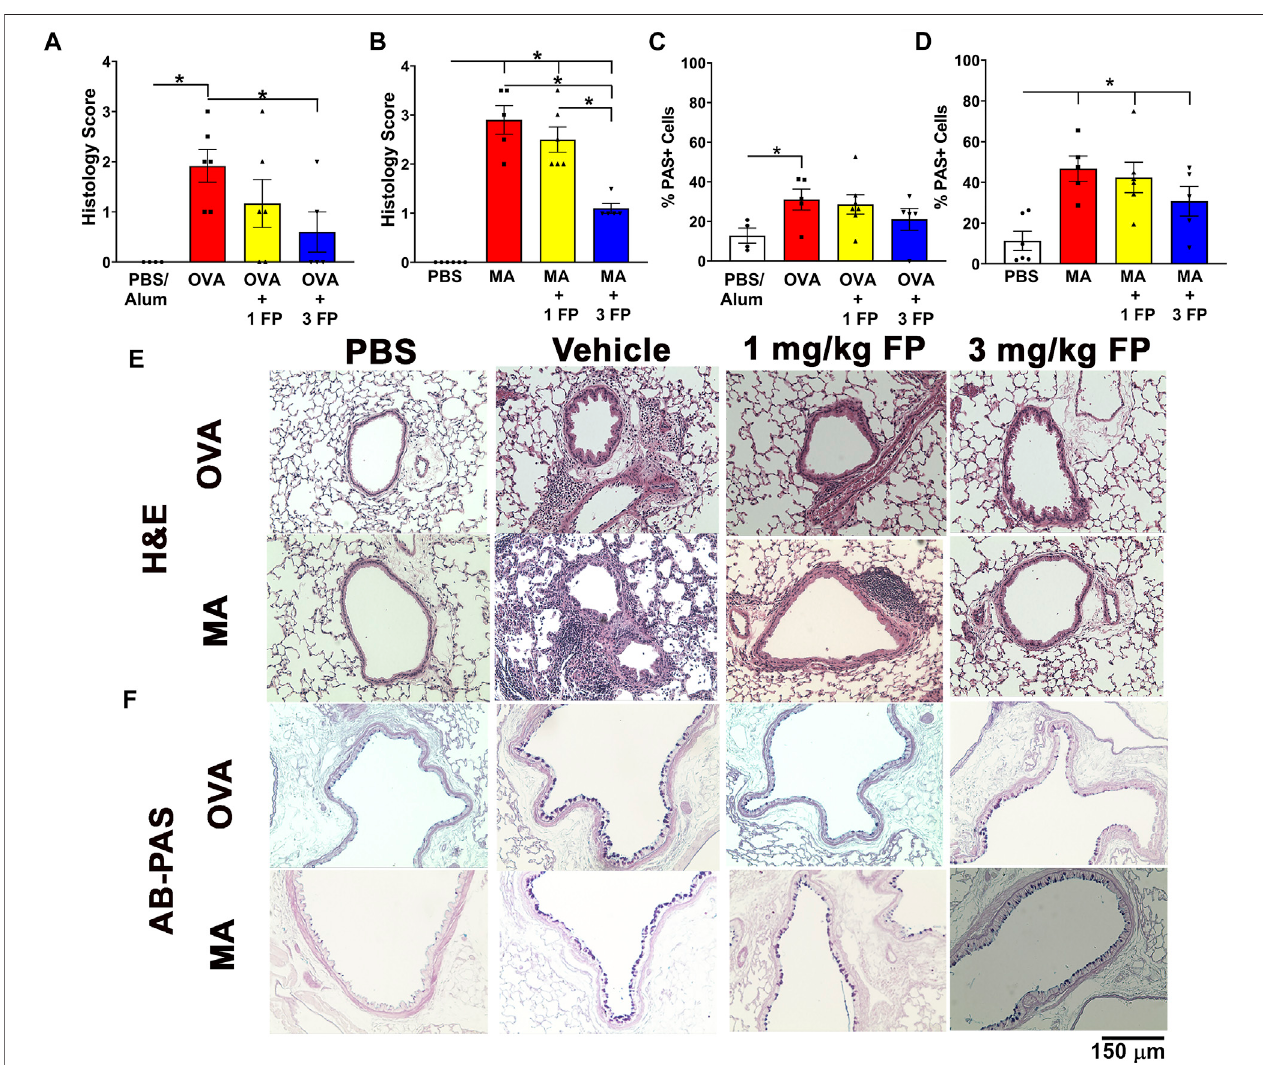
FIGURE 3 | Corticosteroids reduce airway in fl ammation but not mucous cell abundance in acute and chronic allergic airway in fl ammation. (A) OVA- and (B) MA-challenged mice exhibited increased airway in fl ammation that was reduced with 3 mg/kg FP. (C) OVA- and (D) MA-challenged mice exhibited increased airway epithelial abundance that is not reduced by corticosteroids. Representative photomicrographs of (E) H and E- and (F) AB-PAS-stained left lung lobe sections. Data are presented as ± SEM, n = 4-7 mice per group. p < 0.05. * indicates signi fi cant difference between groups.